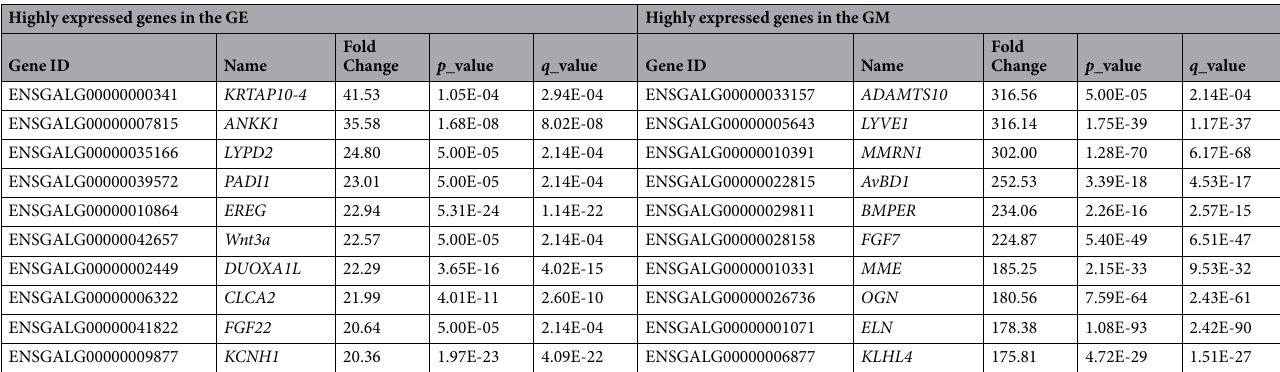
Highly expressed genes in the GM